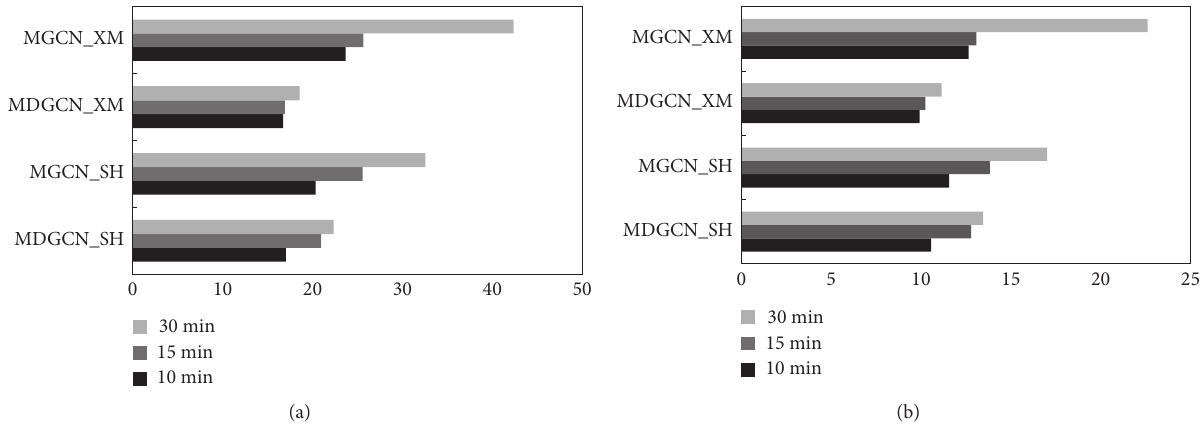
Figure 7: The evaluation of Diff-GCN under different time intervals. (a) RMSE. (b)